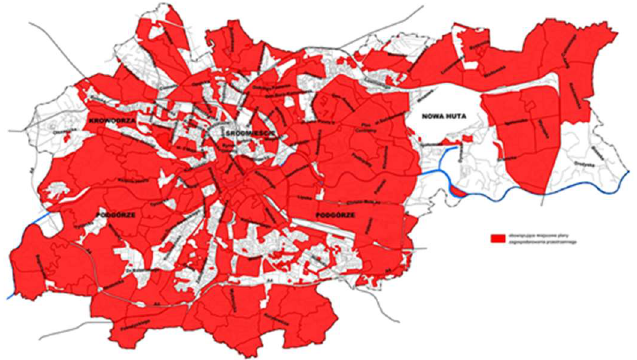
Figure 7. Map of binding sub-local zoning plans (red color) as of 2021. Source: Krakow City Council, https://www.bip.krakow.pl/?dok_id=119734 (accessed on 20 July 2021).